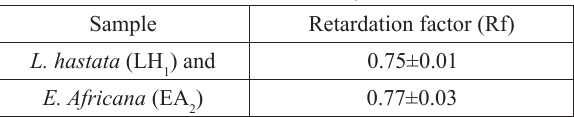
Showing the results of phytochemical quantification